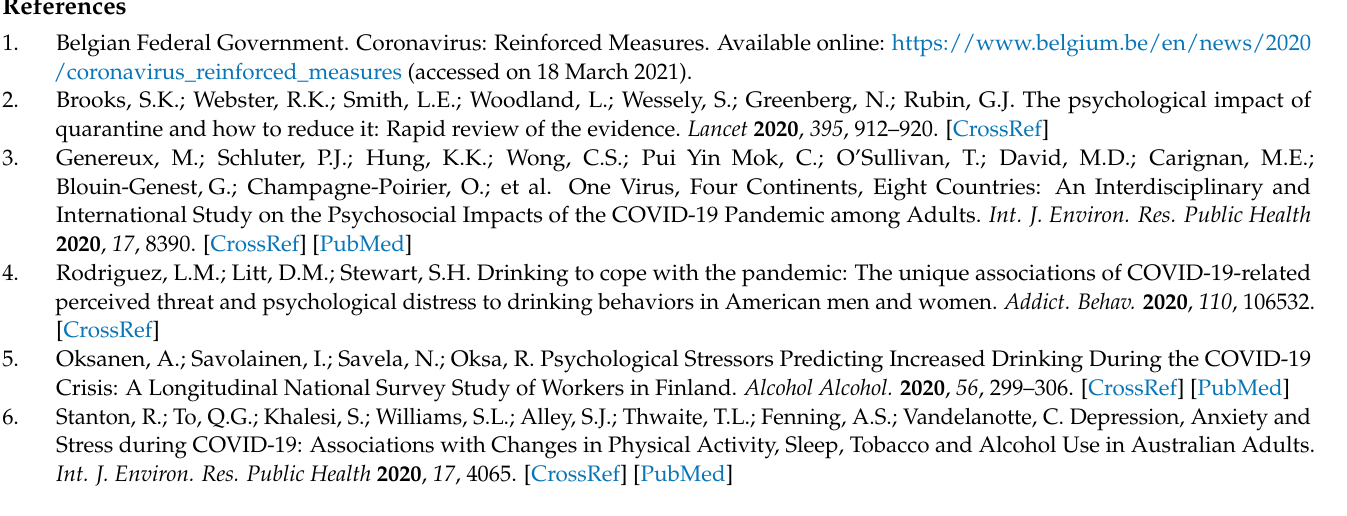
Table S1. Bivariate analyses for alcohol use ( n = 13,404); Table S2. Bivariate analyses for binge drinking ( n = 10,764); Table S3. Bivariate analyses for tobacco use ( n = 2653); Table S4. Bivariate analyses for cannabis use ( n = 1804). Supplementary 2. Missing value and sensitivity analyses. Supplementary 3. Assumption testing. Supplementary 4. Control analyses. Table S5. Multino- mial regression analyses for alcohol use: light drinkers ( n = 11,508) and heavy drinkers ( n = 1896); Table S6. Multinomial regression analyses for binge drinking: light bingers ( n = 9826) and heavy bingers ( n = 938); Table S7. Multinomial regression analyses for tobacco use: low-rate daily smokers ( n = 2038) and high-rate daily smokers ( n = 615); Table S8. Multinomial regression analyses for cannabis use: light cannabis users ( n = 1212) and heavy cannabis users ( n =